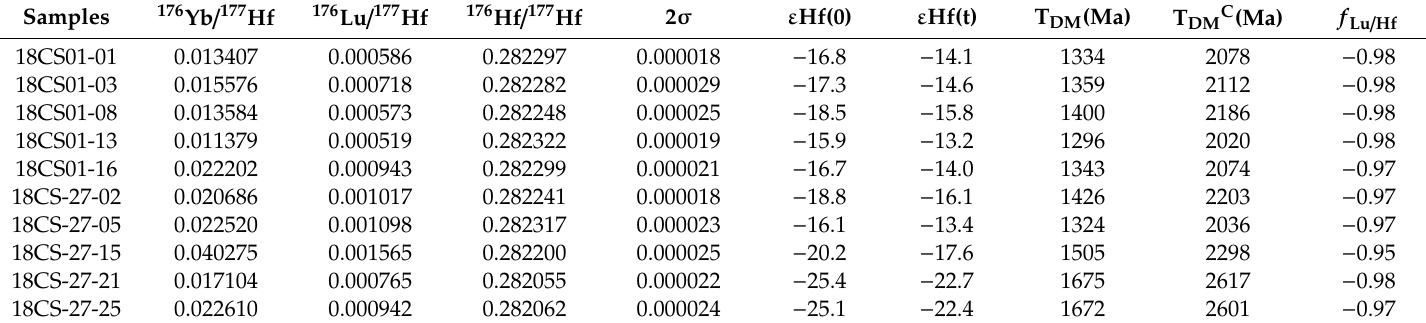
Table 3. Lu–Hf isotopic analysis result of the Chishan alkaline